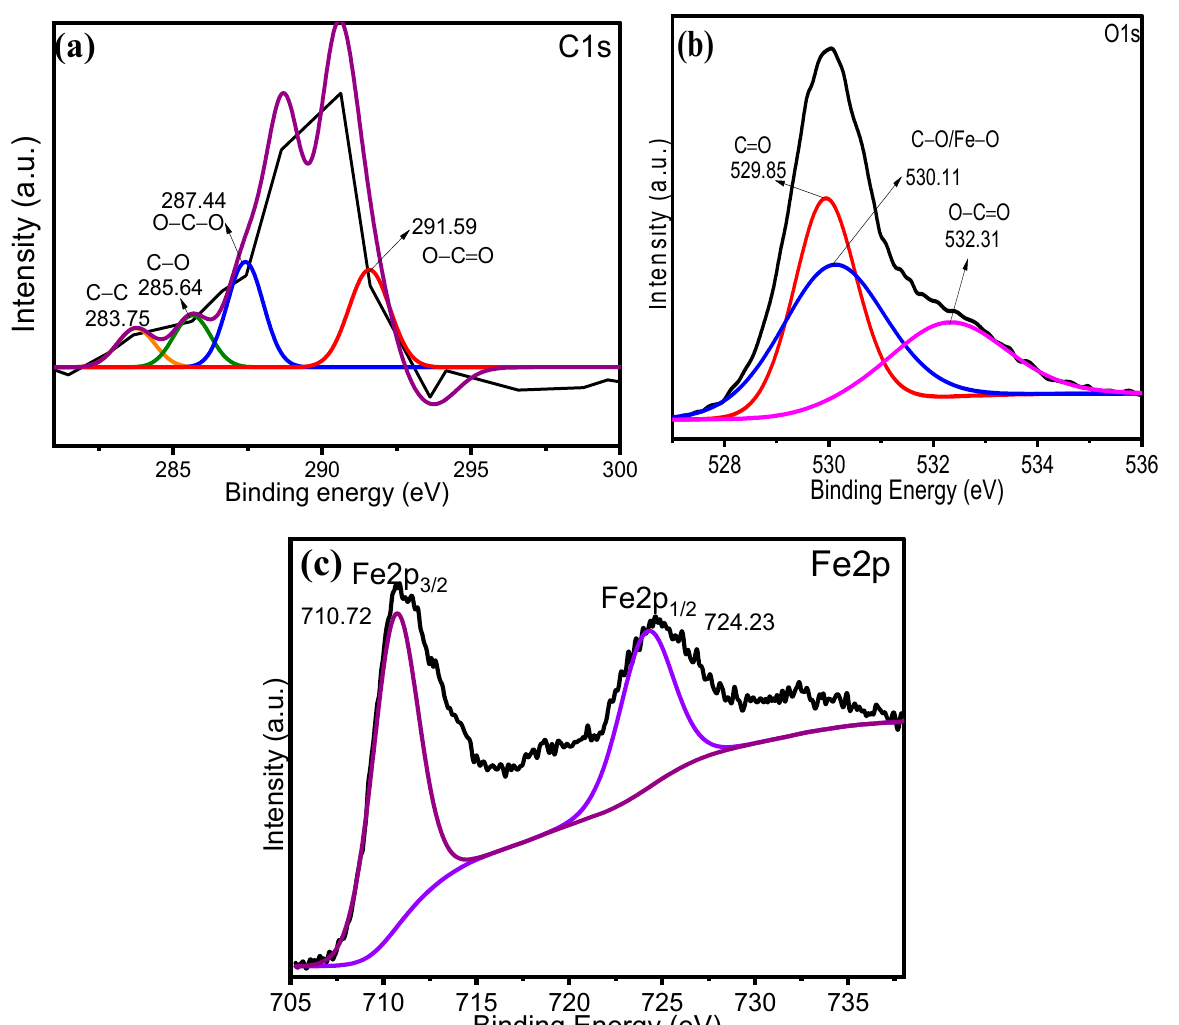
Figure 5. Deconvoluted XPS spectra of ( a ) C1s, ( b ) O1s and ( c ) Fe2p, corresponding to XGFO BNC.